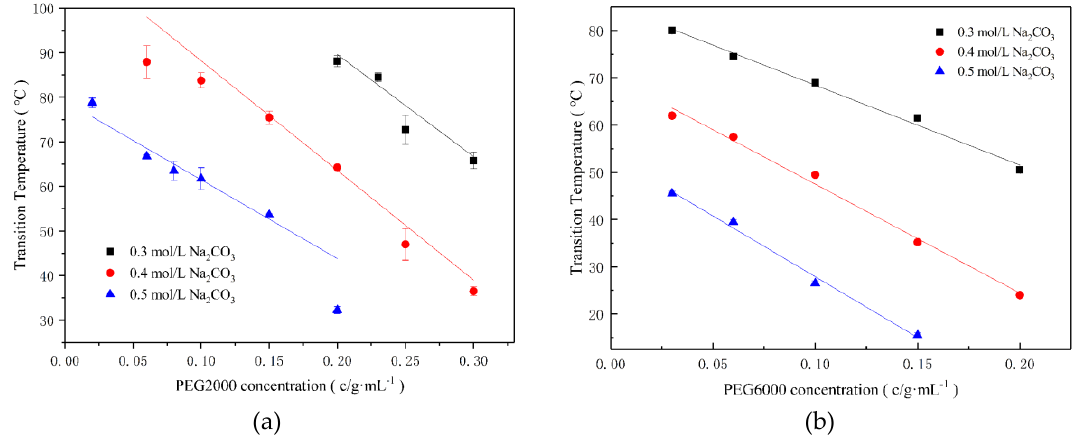
Figure 1. Effects of PEG/Na 2 CO 3 concentration on E-C phase transitions temperature (Tt E-C ). ( a ) Figure 1. E ff ects of PEG / Na 2 CO 3 concentration on E-C phase transitions temperature (Tt E-C ). PEG2000; ( b ) PEG6000. ( a ) PEG2000; ( b )